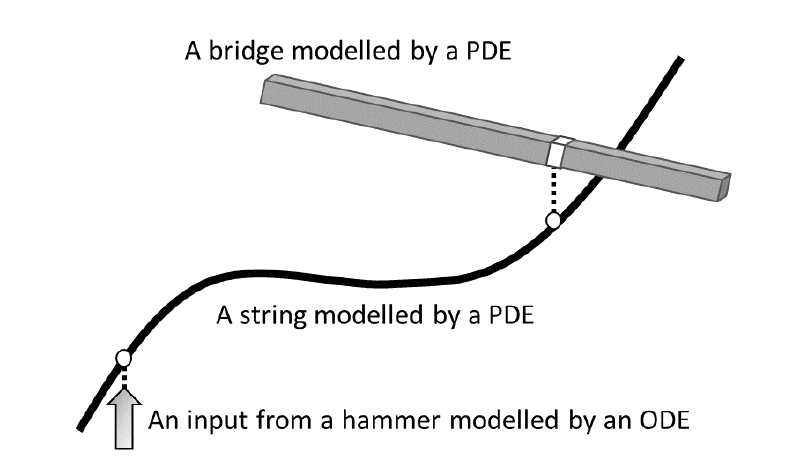
Figure 1. An example of coupled systems (a rough model of a piano). In this example, the string and the bridge are modeled as PDEs, which they are in contact at a single point. Excitation of the string by a hammer is typically modeled as an